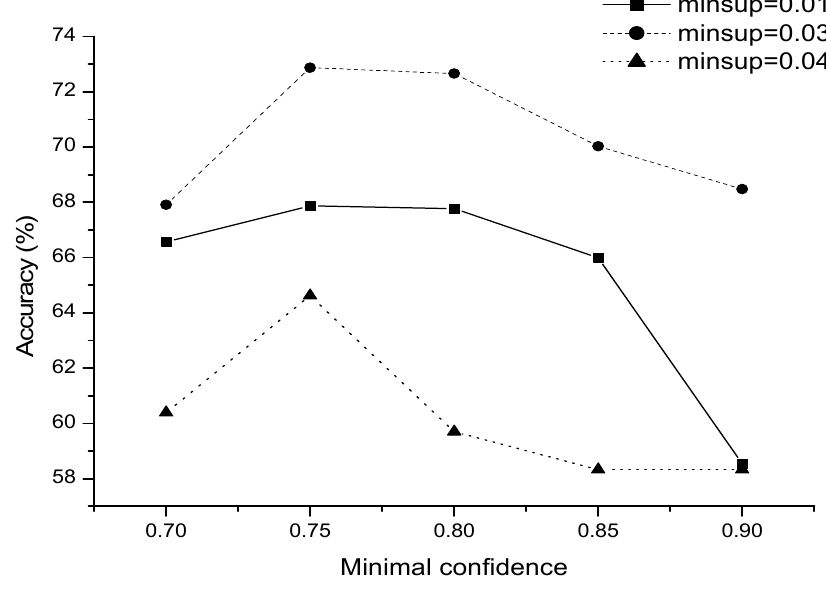
Figure 6. The accuracy of air quality pattern learning.